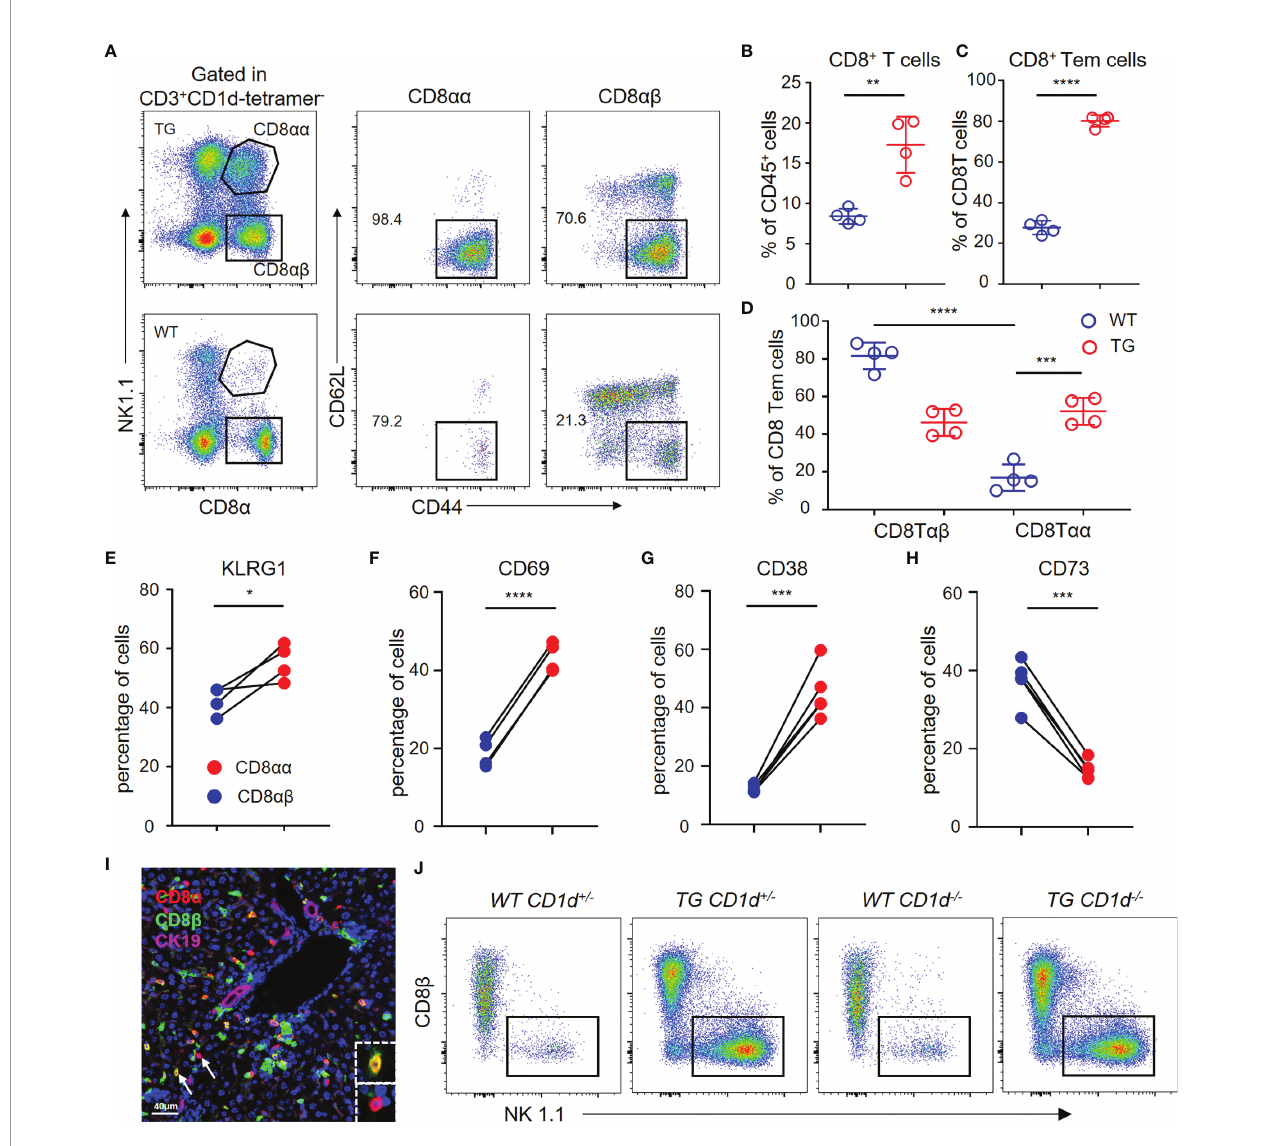
FIGURE 5 | Hepatic CD8 aa T cells in TG mice are terminally differentiated T cells. (A) Gating strategy used for fl ow cytometric examination of the percentage of CD8 + T cells sub-populations. (B – D) Percentage of CD8 + T cells, effector memory CD8 + T cells and CD8 ab /CD8 aa effector memory T cells in WT (n = 4) and TG mice (n = 4). (E – H) Frequency of CD8 ab and CD8 aa T cells in TG mice that express KLRG1 (n = 4), CD69, CD38, and CD73 (n = 5). (I) Representative multiplex immunohistochemistry staining of CD8 aa T cells in liver from TG mice for CD8 a , CD8 b and CK19 scale bar, 40 m m. (J) Representative FACS plot showing the percentage of NK1.1 + and CD8 b - CD8 aa + T cells within the CD3 + CD1d-tetramer - cells from the different groups of mice that included WT-CD1d +/- , TG-CD1d +/- , WT-CD1d -/- and TG-CD1d -/- mice. *, P<0.05; **, P<0.01; ***, P<0.001; ****,